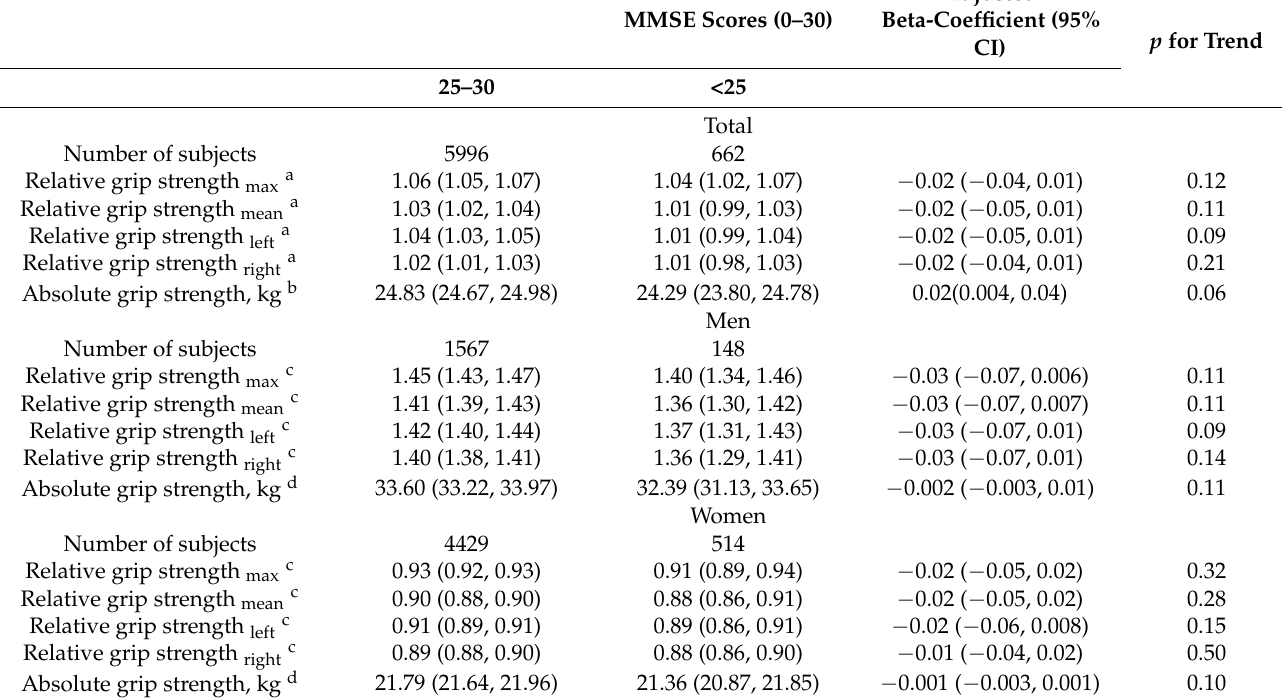
Table 4. Multivariable linear regression of hand grip strength on Mini Mental State Examination (MMSE) groups * for males and females.